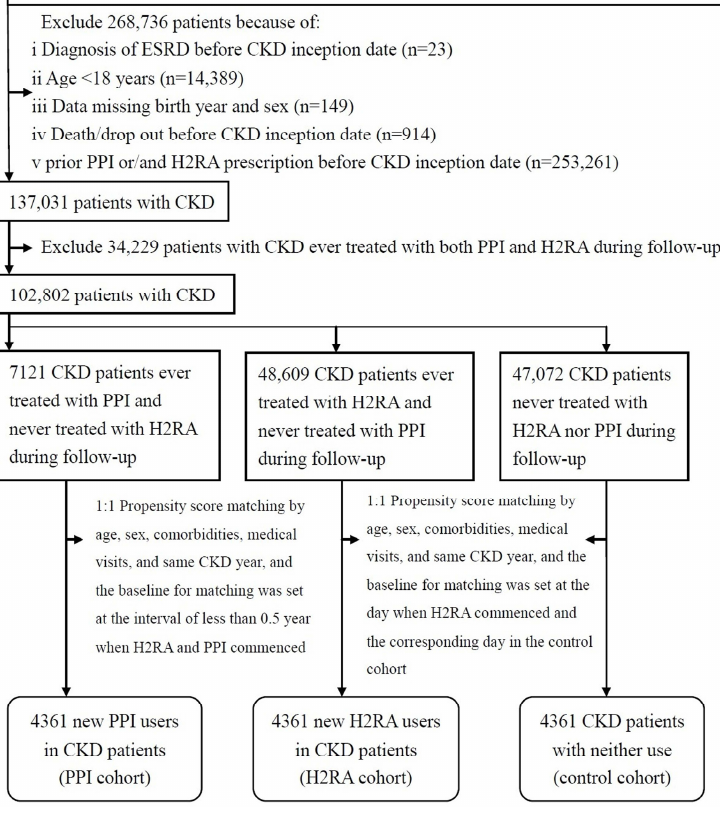
Figure 1. Flow diagram of the enrollment process. Abbreviations: CKD, chronic kidney disease; ESRD, end-stage renal disease; H2RA, H2-receptor antagonist; PPI, proton pump inhibitor.